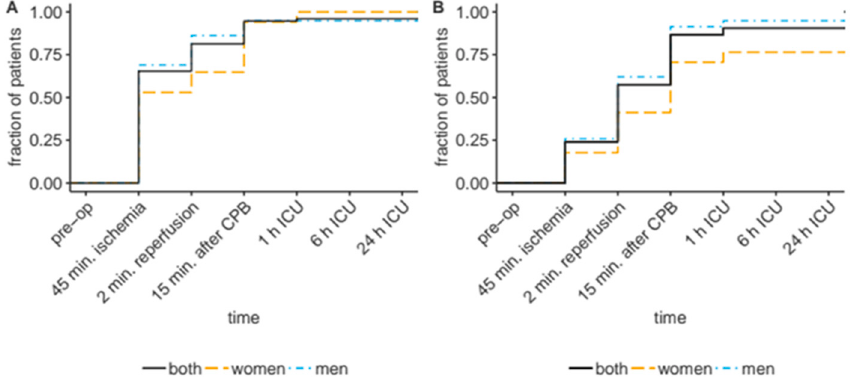
20% in comparison to pre-op levels, or ( B ) by surpassing a predefined cut-off value (0.455 nM), or an